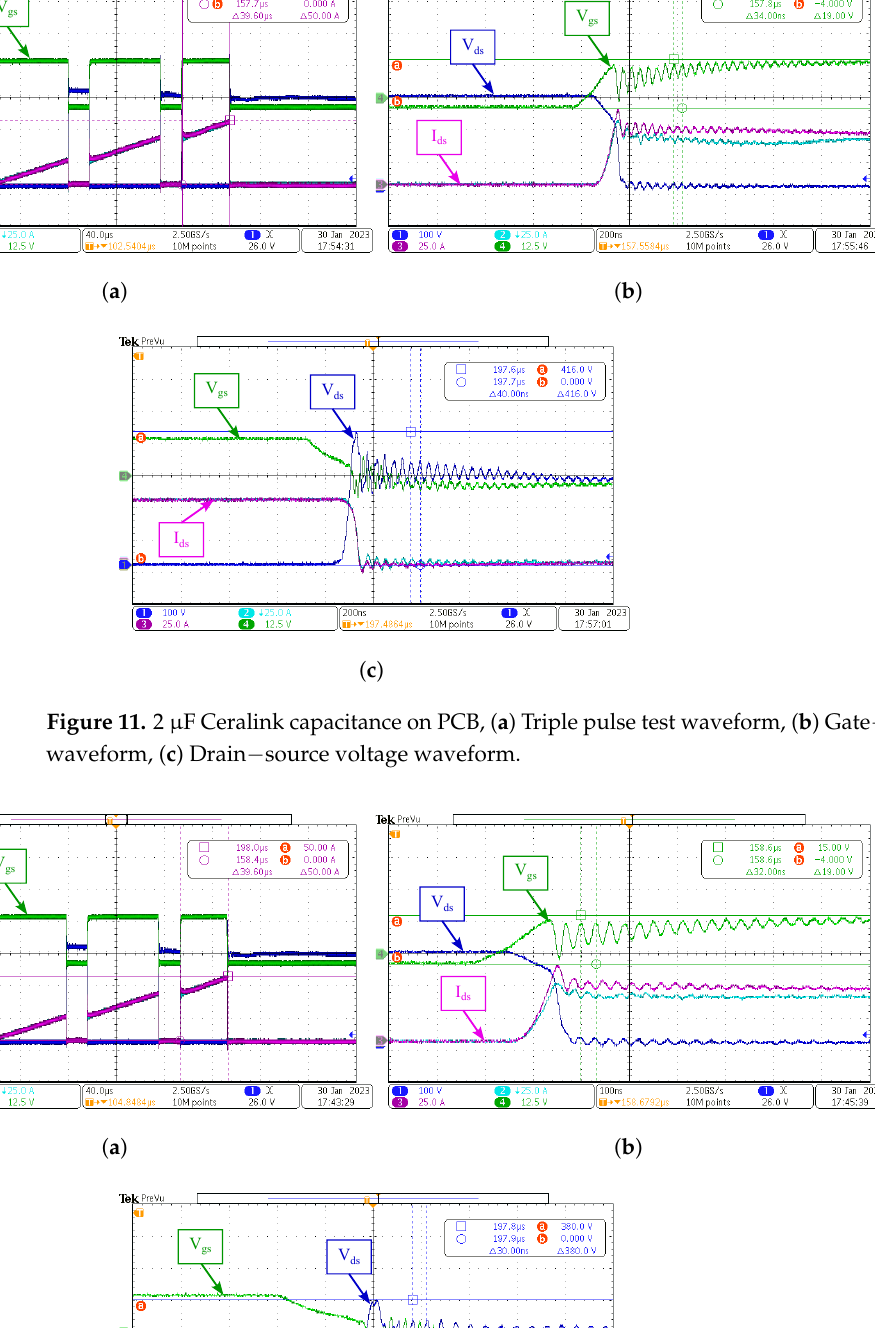
Link input of busbar, ( a ) Triple pulse − source voltage −